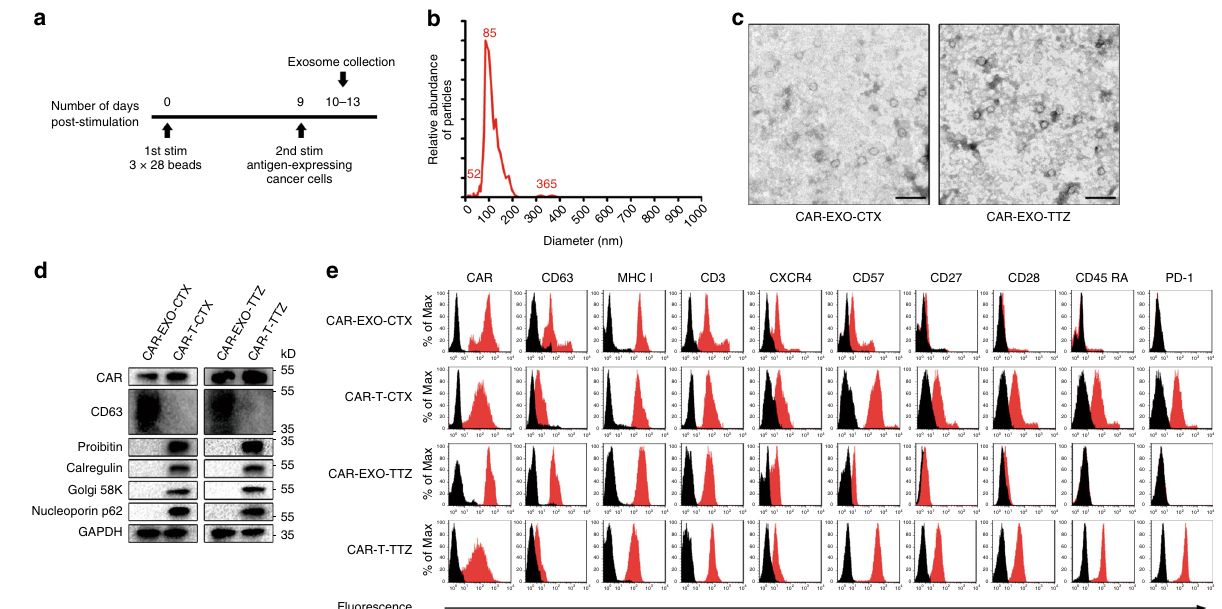
Fig. 3 Characterization of CAR exosomes derived from effector CAR-T cells. a Schematic representation of the enrichment of CAR-containing exosomes from T cells with repeated antigen stimulation. b Size distribution of CAR exosomes as measured by NTA, peaking at an 85-nm diameter. c Transmission electron micrographs of CAR exosomes. The samples were negatively stained with uranyl acetate. Scale bars = 100 nm. d Immunoblots for CAR expression in exosomes compared with cell markers for endoplasmic reticulum (calregulin), Golgi (Golgi 58 K), mitochondrial (prohibitin), or nuclear (nucleoporin p62) markers. e Flow cytometry analyses of CAR exosomes linked to latex beads (4-mm diameter) or CAR-T cells and stained with the indicated primary Abs. The histograms shown in black correspond to the isotype controls of the respective Abs, whereas the red histograms indicate positive fl uorescence. Results shown represent three ( b – e ) independent experiments. Source data ( d ) are provided as a Source Data fi